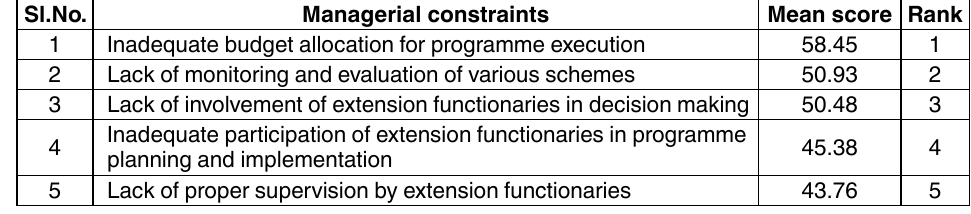
table 4. Managerial constraints as perceived by the FEFs of DDD, Kerala